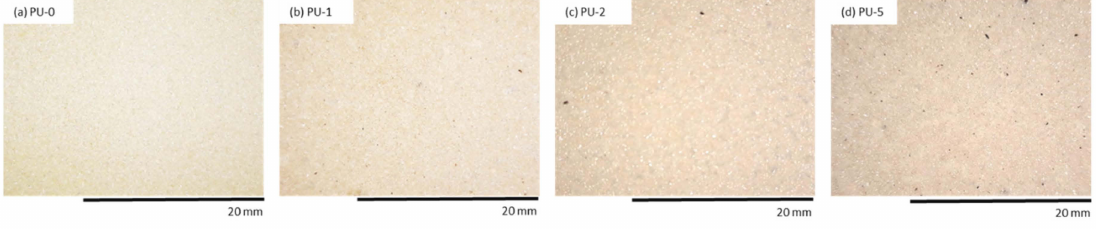
Figure 12. The external surface of ( a ) PU-0, ( b ) PU-1, ( c ) PU-2, ( d ) PU-5 before UV aging.